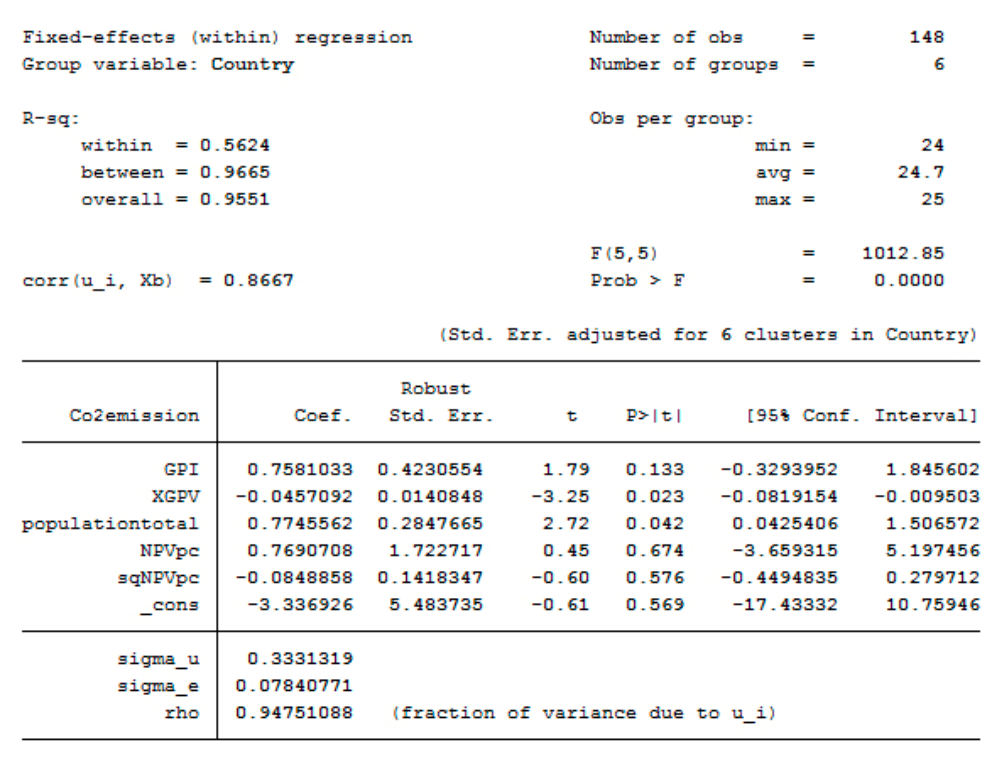
Figure 3. CO2 model with fixed effects (FE). Source: Own calculations according to FAOstat data [27]. Figure 3. CO 2 model with fixed e ff ects (FE). Source: Own calculations according to FAOstat data